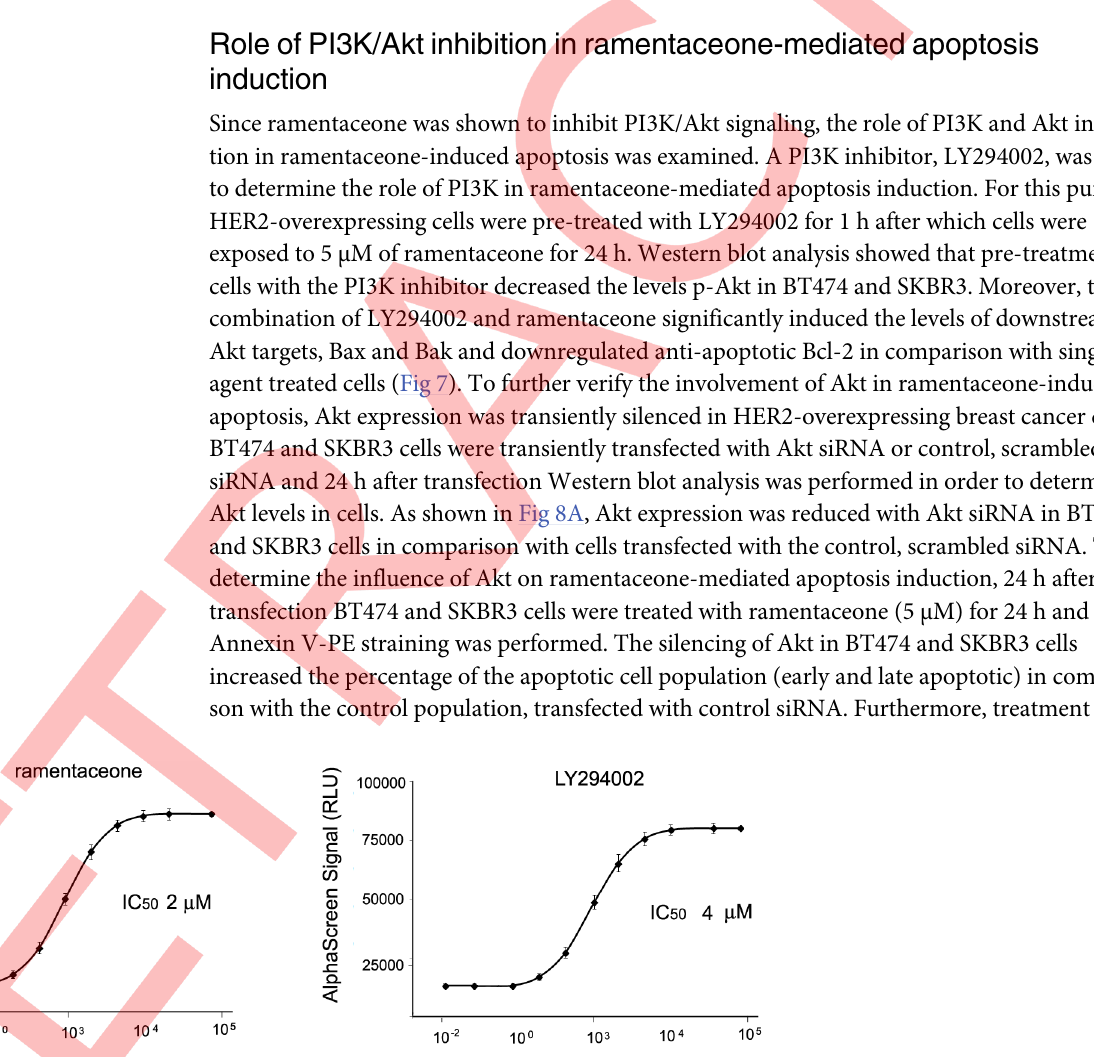
Fig 3. Effects of ramentaceone on the expression levels of PI3K/Akt signaling proteins. (A) Concentration-dependent inhibition of PI3K/Akt signaling. Breast cancer cells were treated with